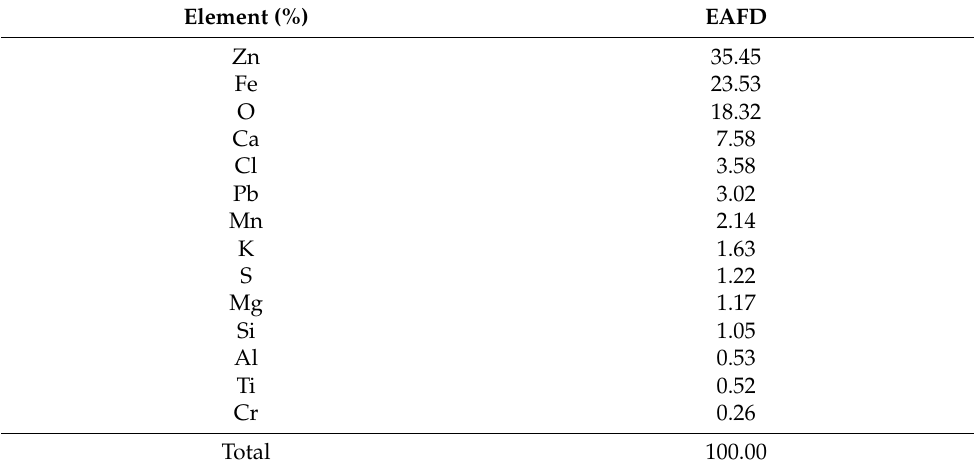
Table 3. Chemical composition of